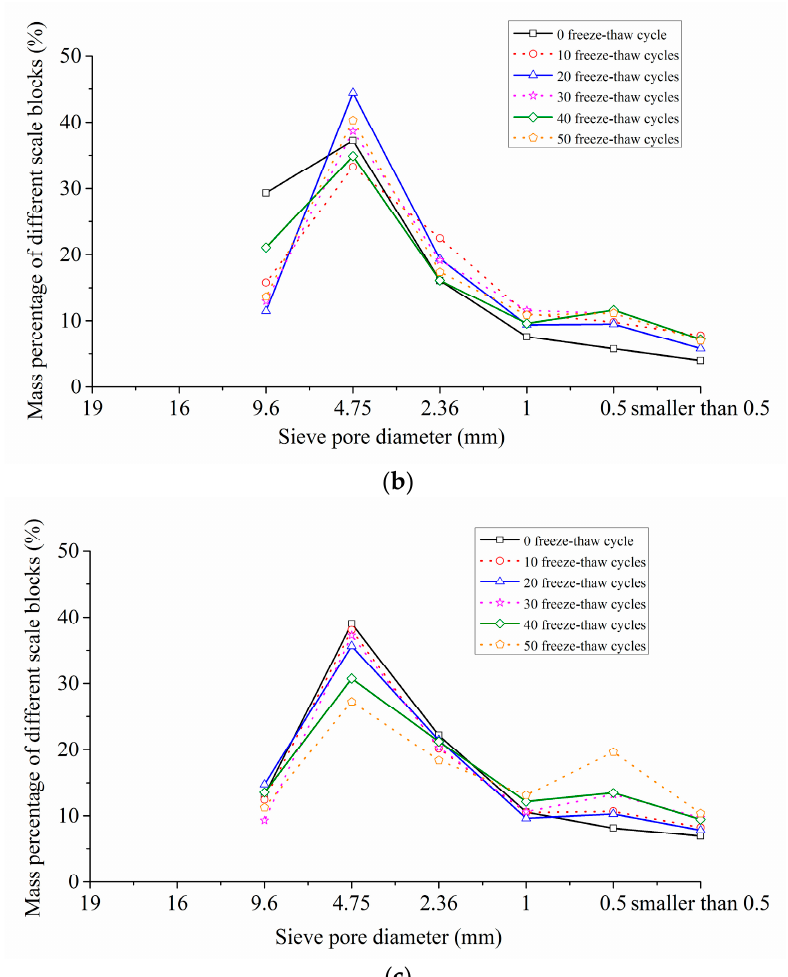
Figure 9. Scale-mass distribution curves of impact fragments. ( a ) 5.4 m/s; ( b ) 8.8 m/s; ( c ) 11.3 m/s.